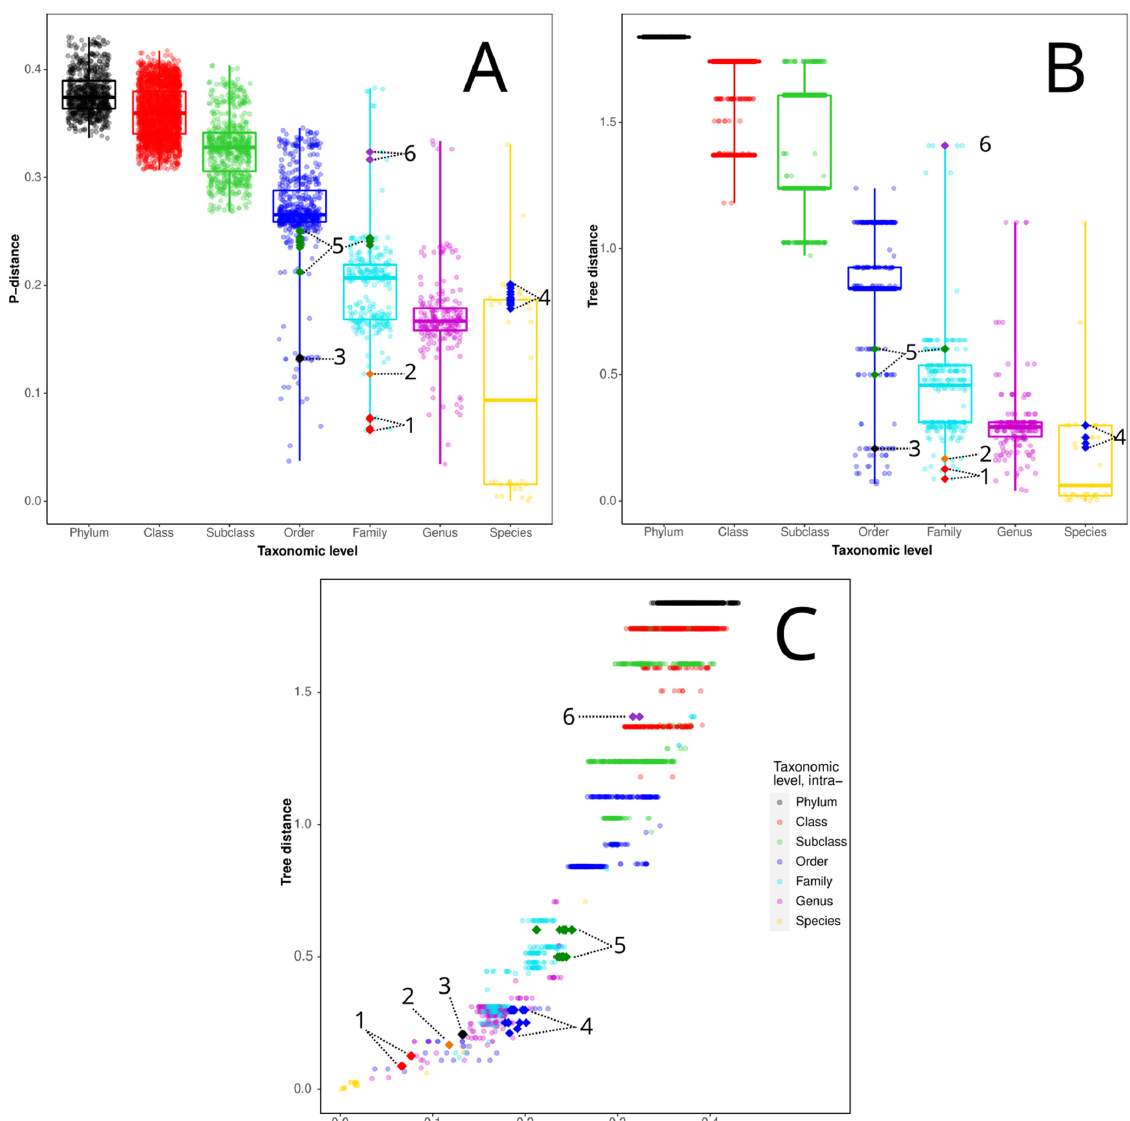
Figure 3. Distribution of p-distances ( A ), tree-based distances ( B ), and dependence of ultrametric tree-based distances from p-distances ( C ) by taxonomic levels according to current sample taxonomy. Colored diamonds indicate distances between selected groups: 1–between Glossiphonia spp. and Baicaloclepsis spp.; 2–between Piscicola geometra and Codonobdella sp.; 3–between Acanthobdella peledina and Paracanthobdella livanowi ; 4–between samples of Eisenia nordenskioldi ; 5–between species of families Hirudinidae and Haemopidae; 6–between samples of combined family Naididae (including Tubificidae).